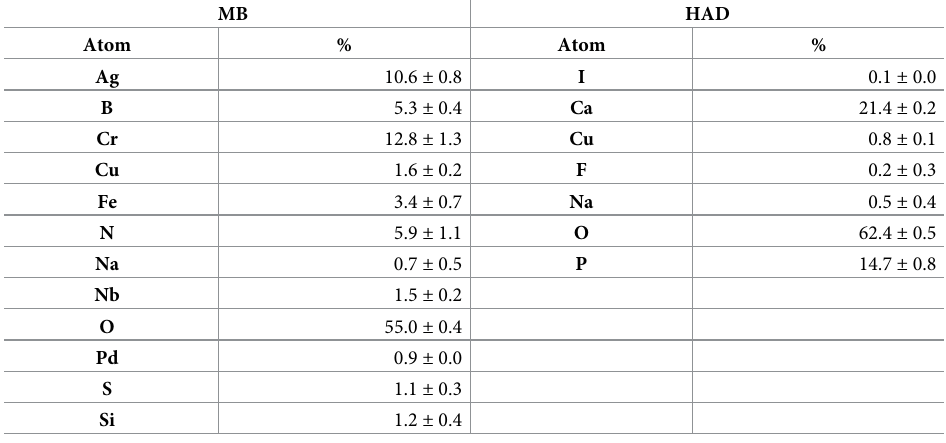
Table 1. Percentage of atoms (%) of on the surface of metallic brackets (MB) and hydroxyapatite discs (HA) incu- bated in distilled water (Mean ± S.D.). MB